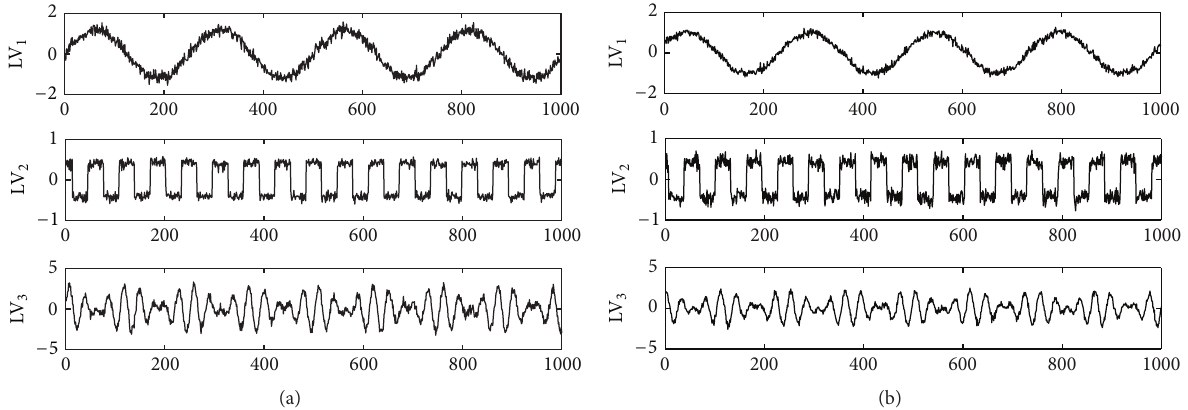
Figure 5: (a) The LVs estimated in X using the proposed PLS + CCA. (b) The LVs estimated in Y using the proposed PLS +